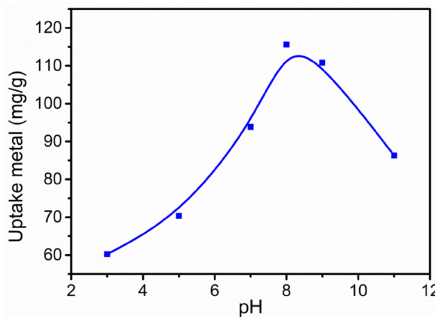
Figure 1. Effect of the pH of the grafting reaction on Pb(II) removal and q e . (Reaction conditions: